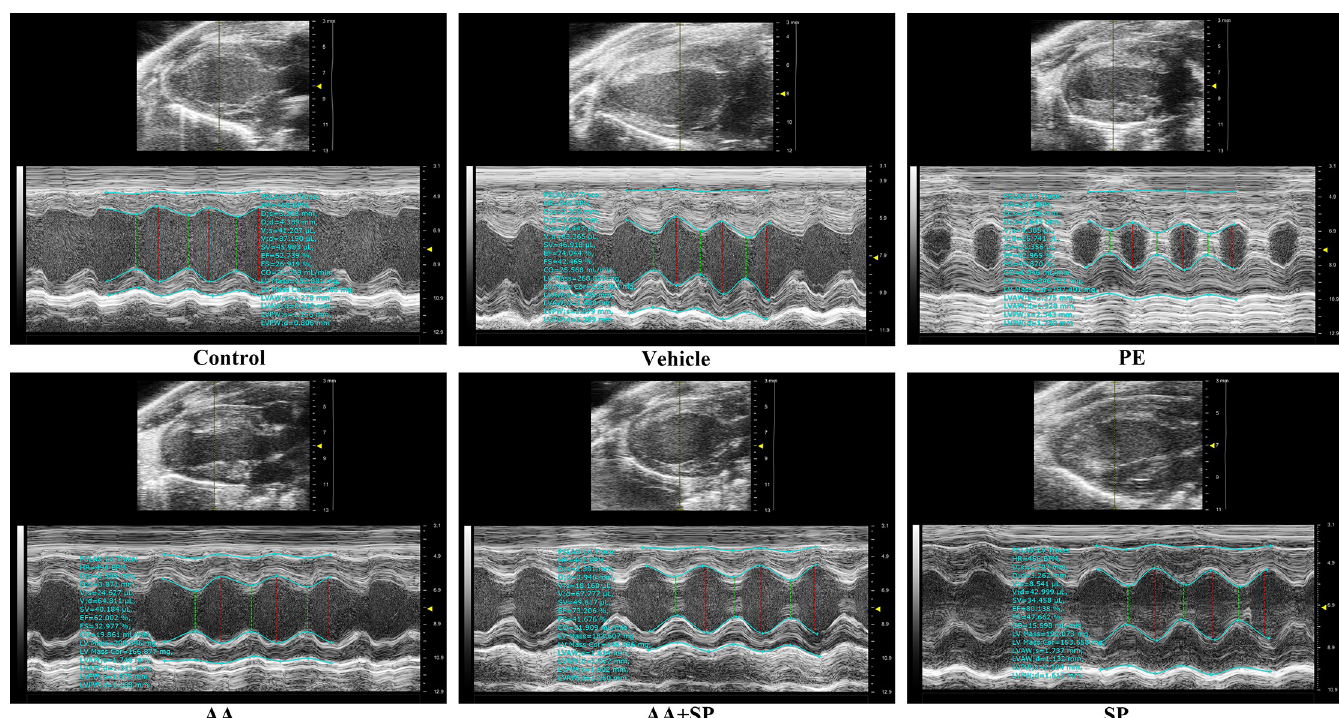
Fig 7. Echocardiographic images of mice. Cardiac function of mice among the six groups were tested by echocardiography. M-mode images obtained from short-axis measurements were used to evaluate left ventricular anterior wall (LVAW) and left ventricular posterior wall (LVPW) thinkness of mice in left ventricular end diastole and left ventricular end systole. Red or green dotted lines represent the diameters of the left ventricle at diastolic or systolic stages. AA: anacardic acid, PE: phenylephrine, DMSO: dimethylsulfoxide, SP: SP600125 (JNK inhibitor).